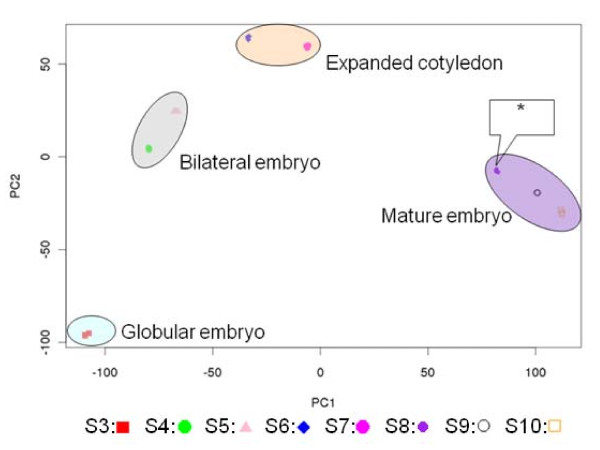
The transcriptome dynamics during Arabidopsis seed development. The normalized, log2-transformed expression data for the 24 samples were subjected to principal component analysis (PCA) using the R prcomp function [83]. PC1 and PC2 are the first two principal components in the dataset. Different symbols and colours shown at the bottom of the figure were used for different seed developmental stages to show the relationship between molecular and morphological phenotypes. As in Table 1, the different samples are as follows: S3: C globular stage; S4: D bilateral stage; S5: D bilateral stage; S6: E expanded cotyledon stage; S7: E expanded cotyledon stage; S8: E expanded cotyledon stage; S9: F mature embryo stage; S10: F mature embryo stage.